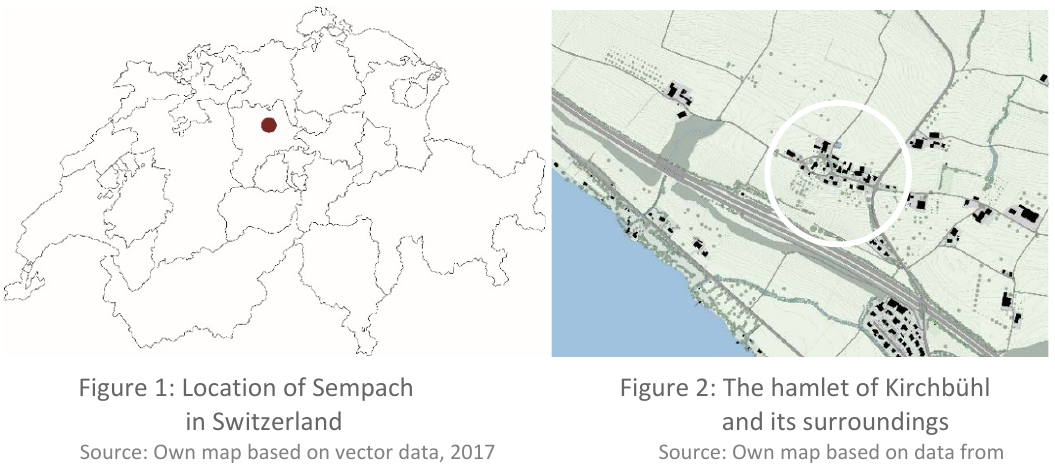
Figure 1: Location of Sempach Figure 2: The hamlet of Kirchbühl in Switzerland and its surroundings Source: Own map based on vector data, 2017 Source: Own map based on data from the official cadastral survey,